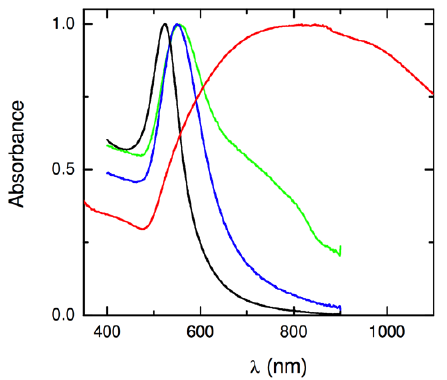
Figure 6. UV-Vis absorption spectral evaluation in one-pot synthesis: Black (gold nanoparticles); blue and green (incomplete nanoshells); and red: Complete gold nanoshells on silica. Reprinted with permission from Reference [53]. Copyright (2009) American Chemical Society.